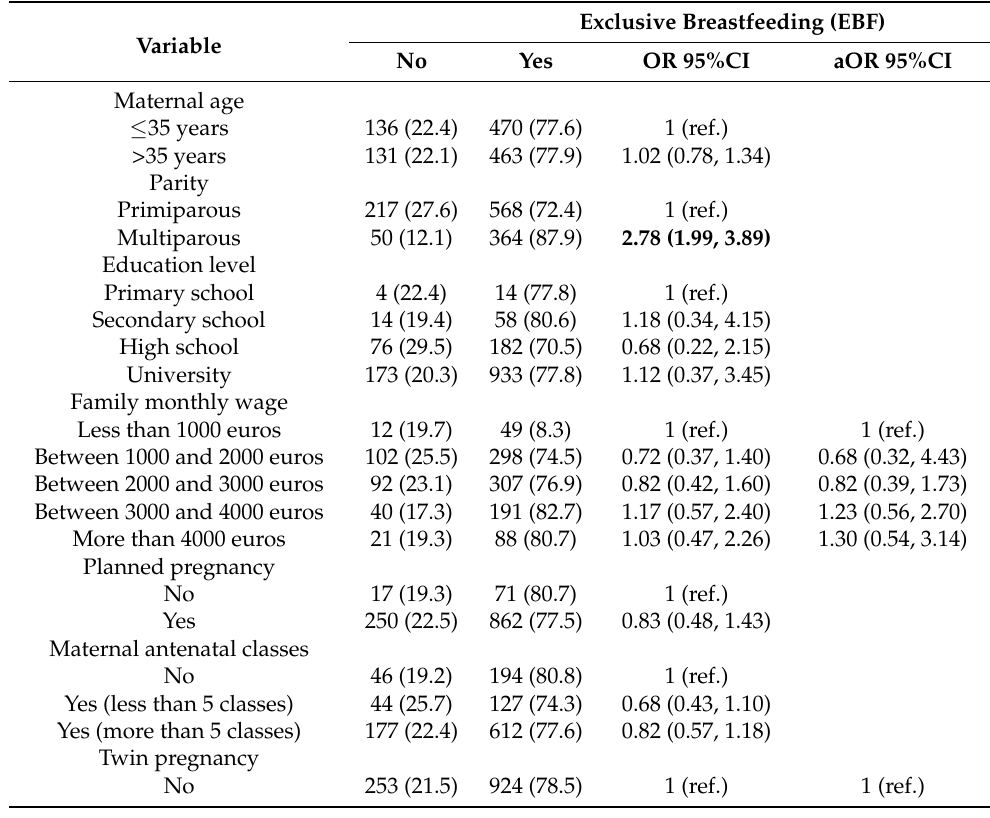
Table 2. Association between the different variables and the maintenance of exclusive breastfeeding after hospital discharge. Bivariate and multivariate